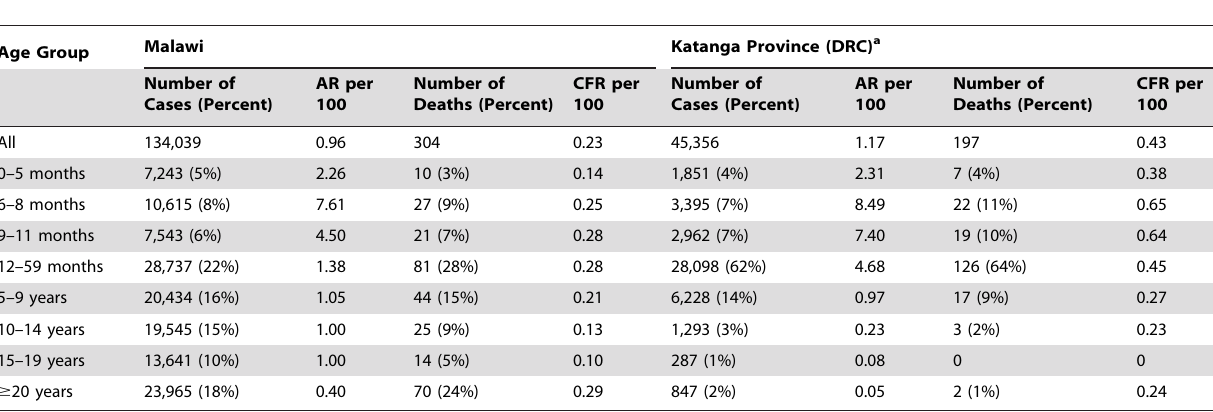
Table 1. Measles cases, deaths, attack rates , and case fatality ratios by age group, reported in Malawi between week 1 and week 52 of 2010 and in Katanga Province between week 23 of 2010 and week 52 of